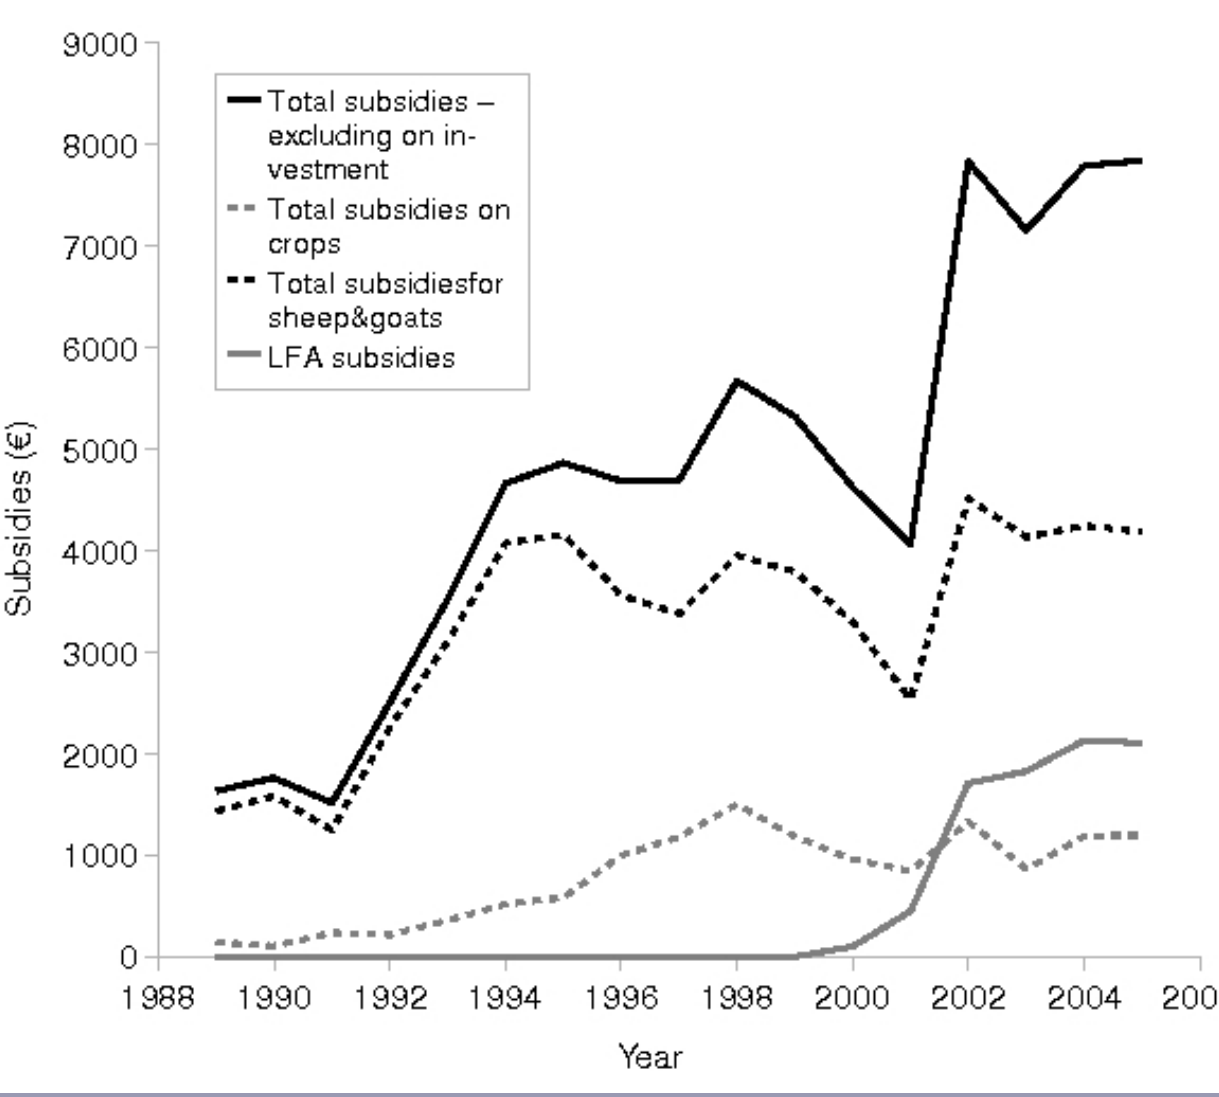
Figure 9. Average amount of subsidies received by sheep and goat specialists in Crete between 1989– 2005